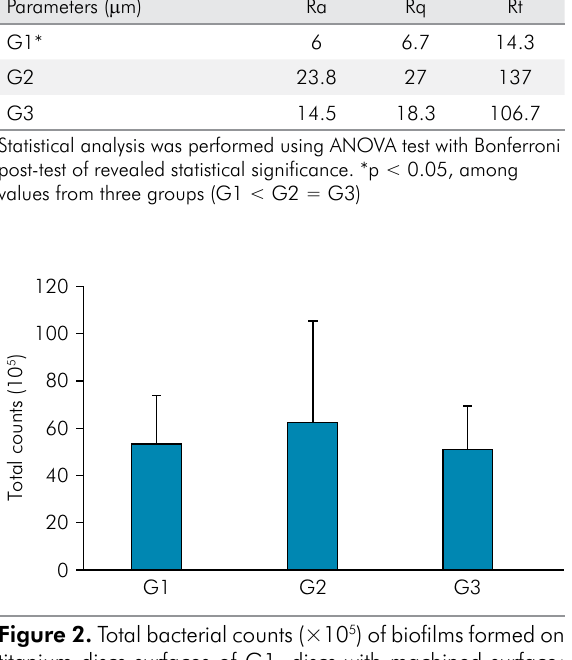
Table. Surface roughness ( μ m) of three titanium disc groups: G1, conventional titanium discs with machined surface; G2, AM-produced titanium discs with chemical treatment; and G3, AM-produced titanium discs without chemical treatment.